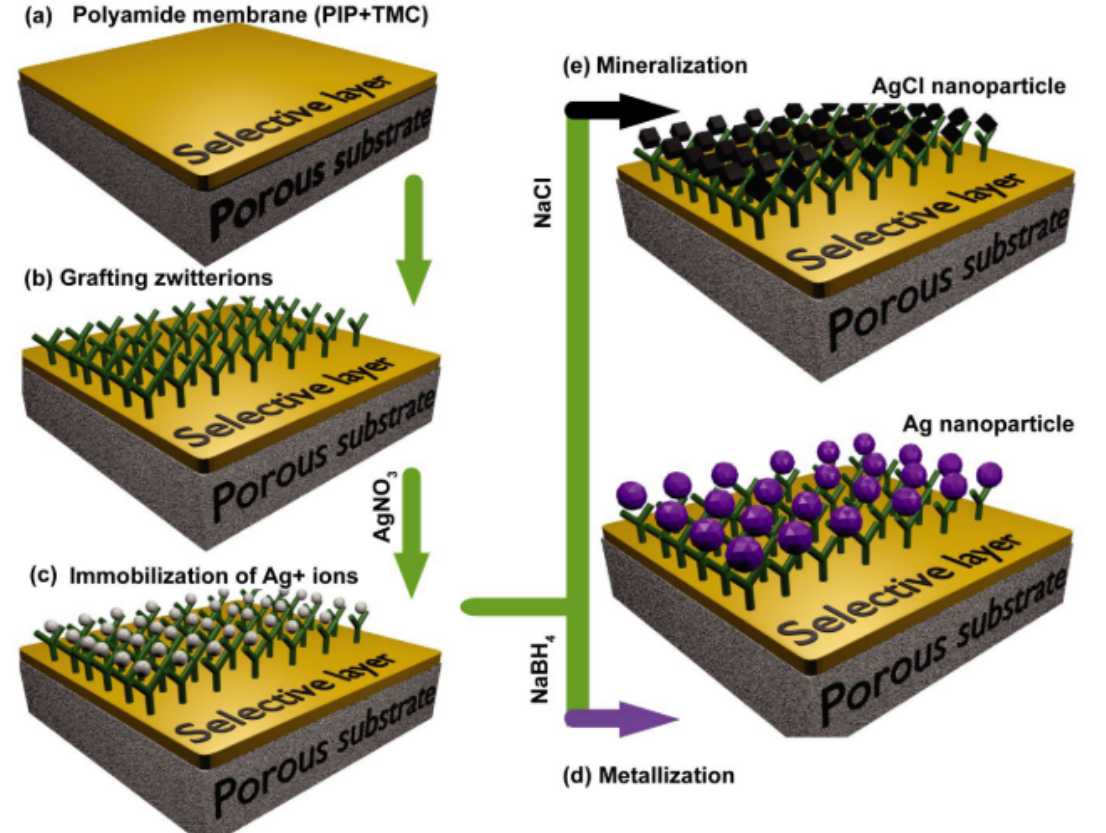
Figure 8. ( a ) TFC membranes comprising polyamide selective layers (yellow) and porous support (grey), ( b ) membrane functionalized with zwitterions (green), followed by ( c ) Ag ions (silver) deposition via immersion in AgNO3 solution. These membranes were immersed in different solutions to obtain ( d ) metallized membranes that contain Ag nanoparticles (purple) and ( e ) mineralized mem- branes that contain AgCl nanoparticles (black) [9] (Copyright 2019. Reproduced with permission from the American Chemical